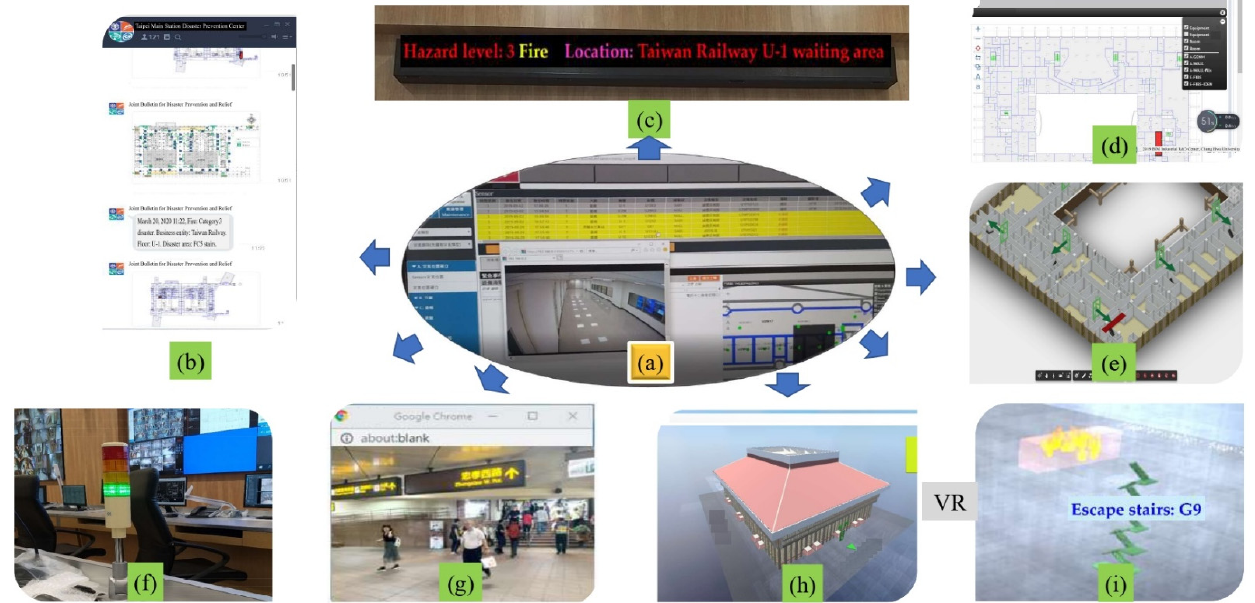
Figure 12. Disaster management: One-click integration to automatically trigger response and report to the fire department and co-construction units. (Source: Research Data). (a) One-click trigger; (b) LINE report; (c) Marquee information; (d) Disaster location; (e) BIM escape; (f) Level-3 signal trigger; (g) CCTV; (h) Nearest exit; (i) Nearest fire escape.